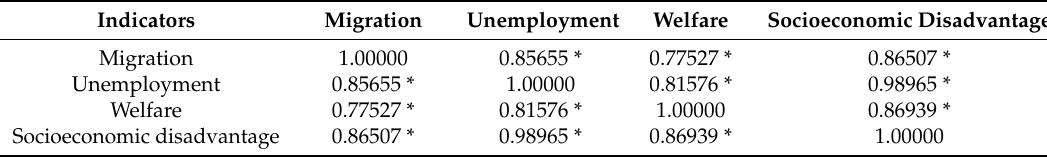
Table 4. Spearman rank correlation coefficients between social context